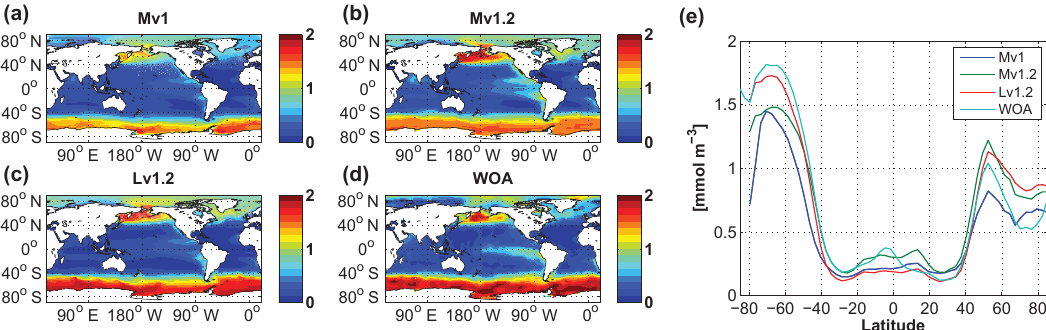
Figure 10. Surface phosphate concentration (mmolm − 3 ) averaged over the years 1965 to 2007 for the model configurations (a) Mv1, (b) Mv1.2, (c) Lv1.2, and (d) surface PO 4 concentration taken from the World Ocean Atlas gridded data set. Panel (e) displays the zonal mean of each field presented in panels (a–d) .